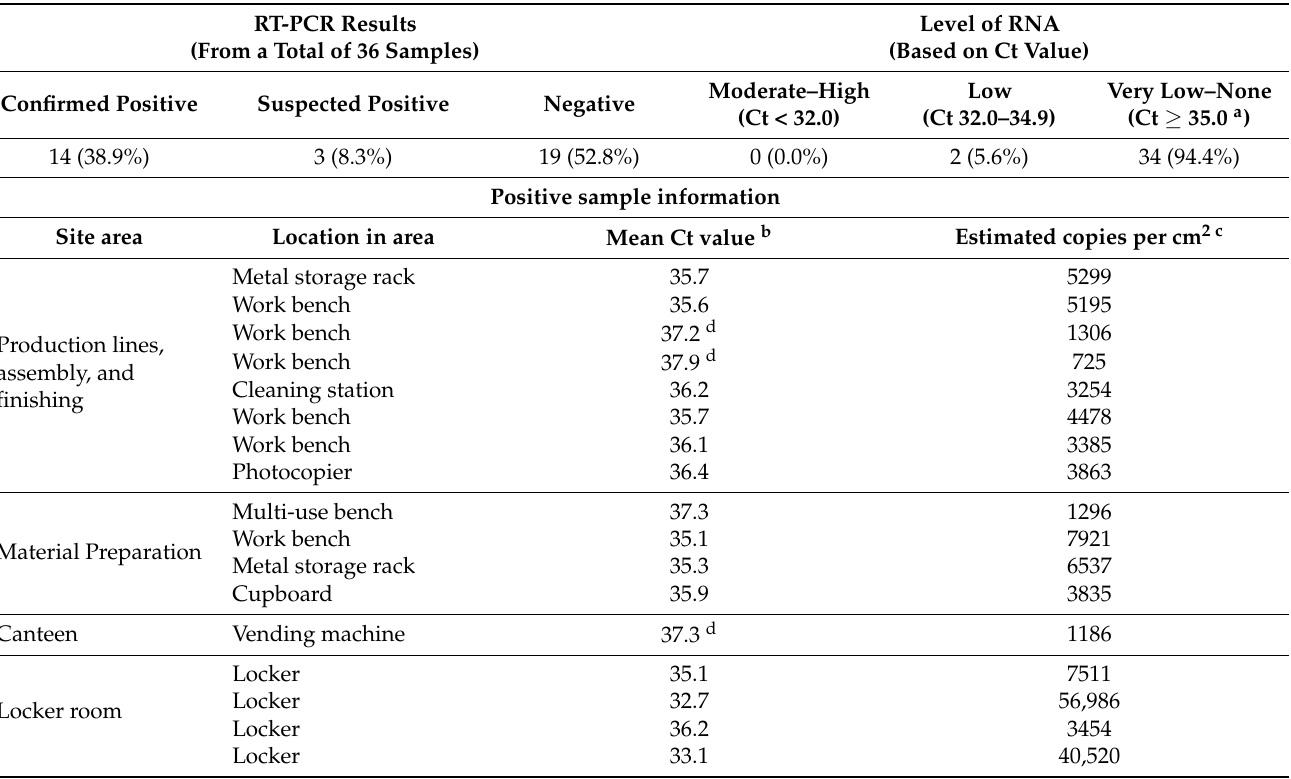
Table 2. SARS-CoV-2 RNA results of 36 surface samples taken from various locations following an outbreak at an automotive manufacturing site—England, United